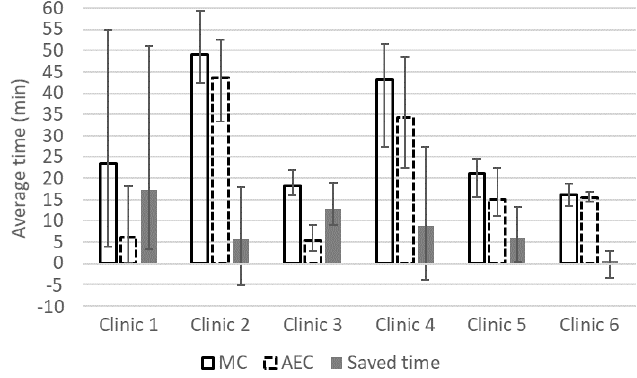
Figure 1. Average manual contouring time (MC bar), automated and edited contouring time (automated and edited contouring (AEC) with dashed line), time saved (filled bar) and range (error bars) in minutes for prostate, bladder, seminal vesicles, rectum, left and right femoral heads and penile bulb. Table 1. Average similarity scores (DSC, S-DSC and HD95) and average absolute and relative volume di ff erences with one standard deviation (Di ff _cm3 and Di ff %) between manual contouring (MC) and automated contouring (AC) methods from 30 patients and 45 scans in six clinics by 13 experts. ROI DSC